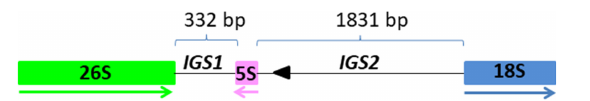
FIGURE 1 | The position and organization of 5S insertion within the 26S-18S intergenic spacer. The 26S, 5S, and 18S genic regions are in green, pink and blue boxes, respectively. The size of IGS1 and IGS2 are depicted with thin lines above the units. Direction of transcription is illustrated by thick arrows below the genes. Arrowhead indicates sequence homologous to MITE family DTM_Glm17 from Glycine max .